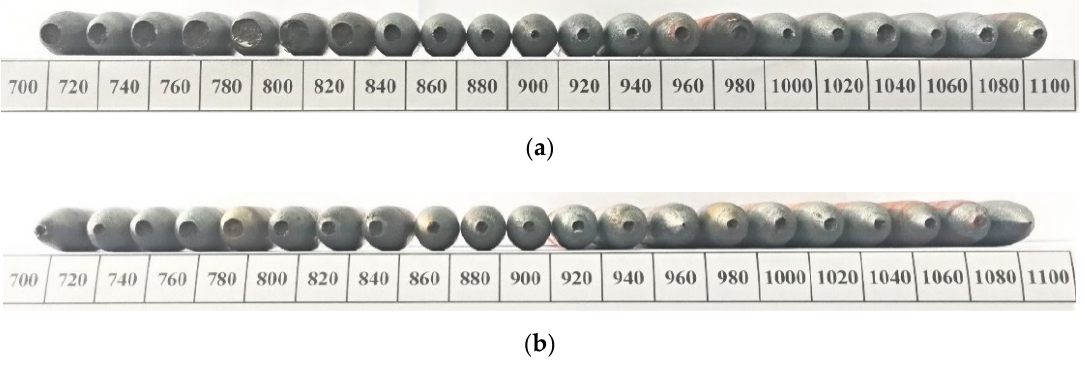
( b ) Figure 8. Comparison of fracture appearance of tensile specimens before and after magnesium treatment (780 °C). ( a ) Before magnesium treatment. ( b ) After magnesium treatment. 3.2. Solidification Structure Analysis Picric acid corrosion was performed on specimens from the central area of the slab thickness before and after the magnesium treatment. The appearances of their original austenite grains were compared, and the results are shown in Figure 9. The original austenite grain boundary was outlined using the proeutectoid ferrite structure precipitating along the original austenite grain boundary [26]. It can be seen that the austenite grain size after the magnesium treatment was smaller than that before